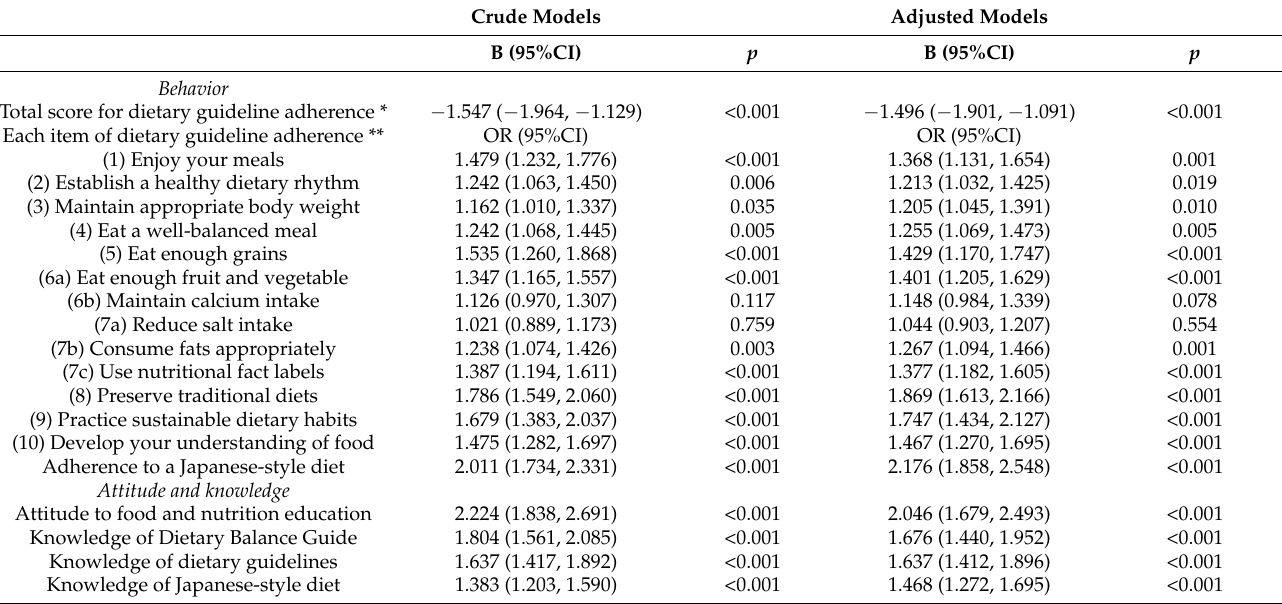
Table 2. Relationships between food production experience and behavior, attitude, and knowledge of dietary recommendations (N = 3461).